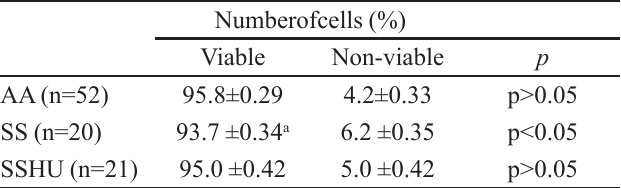
TABLE II - Influence of treatment with HU on cell viability evaluated by exclusion assay with Trypan Blue dye in neutrophils from patients with sickle cell anaemia